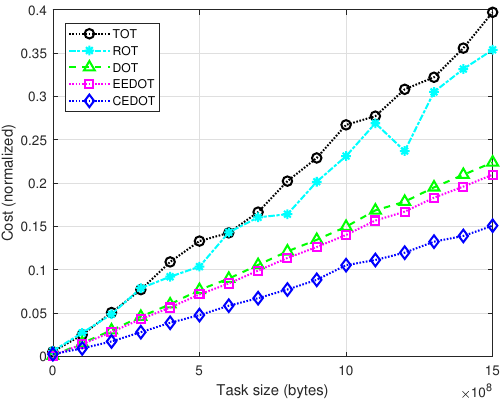
Figure 4. Cost for different task sizes.